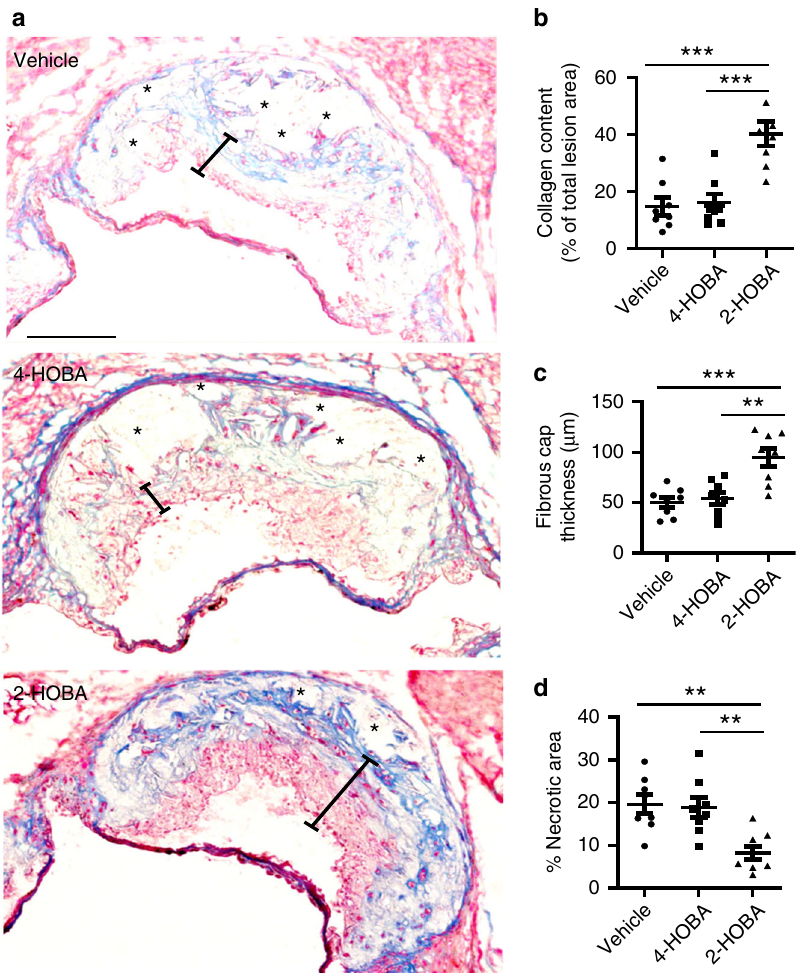
Fig. 3 2-HOBA promotes features of stable atherosclerotic plaques in Ldlr − / − mice. a – d Masson ’ s Trichrome stain was done to analyze characteristics associated with atherosclerotic lesion stability in proximal aorta sections of Ldlr − / − mice. Representative images ( a ) of Masson ’ s Trichrome stain in aorta root sections and quantitation of aortic root collagen content ( b ), fi brous cap thickness ( c ), and necrotic area ( d ). Blue shows collagen, red, cytoplasm, black, nuclei. Scale bar = 50 μ m. Quantitations were done using ImageJ software. a – d n = 8 biologically independent mice per group. Data are presented as mean ± SEM. One-way ANOVA with Bonferroni ’ s post hoc test. b p values of 2-HOBA vs 4-HOBA and 2-HOBA vs vehicle are ***0.0002 and ***0.0001. c p values of 2-HOBA vs 4-HOBA and 2-HOBA vs vehicle are **0.0015 and ***0.0006. d p values of 2-HOBA vs 4-HOBA and 2-HOBA vs vehicle are **0.0058 and **0.0031. Source data are provided as a source data fi